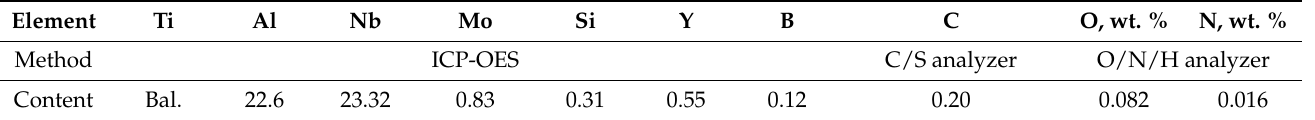
Table 1. Chemical composition of the Ti 2 AlNb-CYB powder (in at. %).